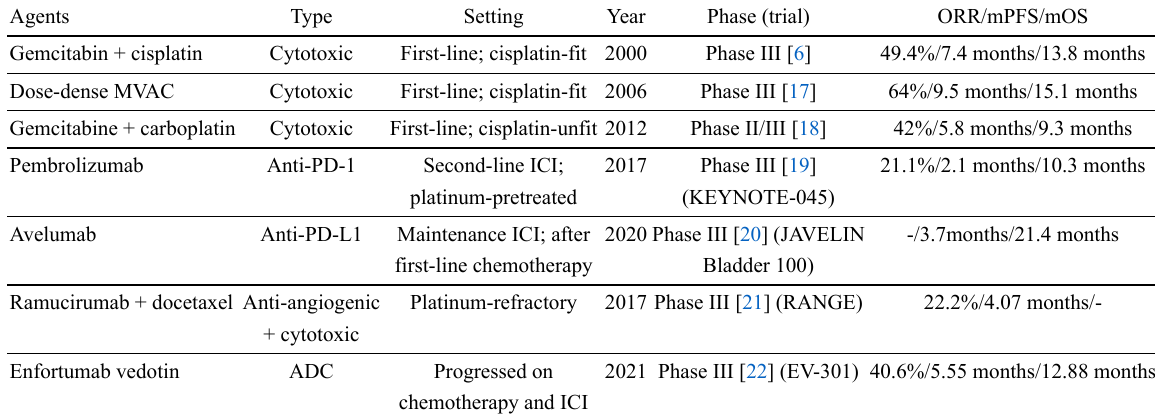
Table 1. Pivotal clinical trials in patient with metastatic urothelial